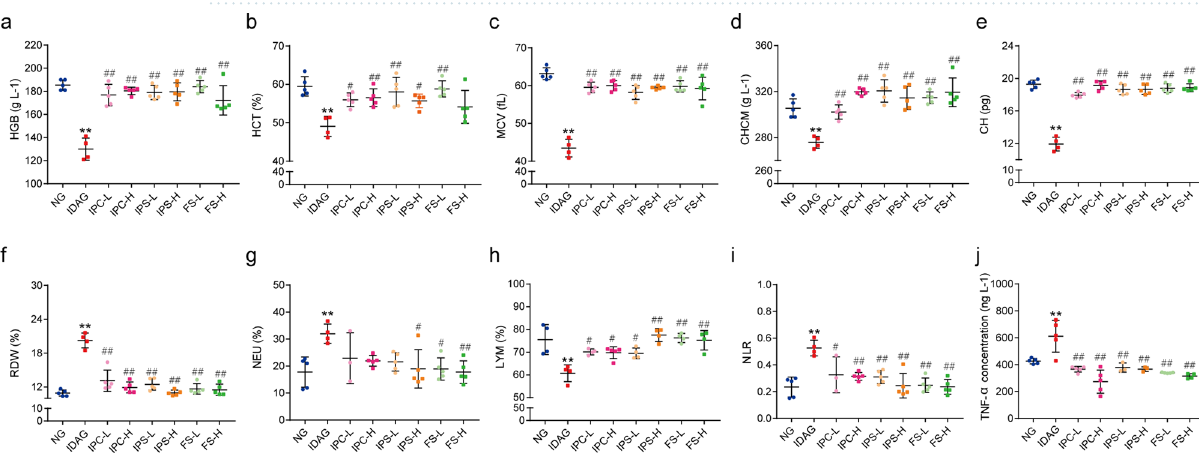
Table 1. Pregnancy outcome of maternal rats. * p < 0.05, ** p < 0.01, compared with NG, # p < 0.05, ## p < 0.01, compared with IDAG. One-way ANOVA followed by Tukey multiple comparison test was used for comparison among 8 different groups.